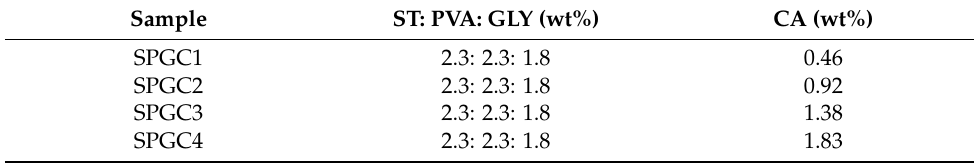
Table 1. The composition of